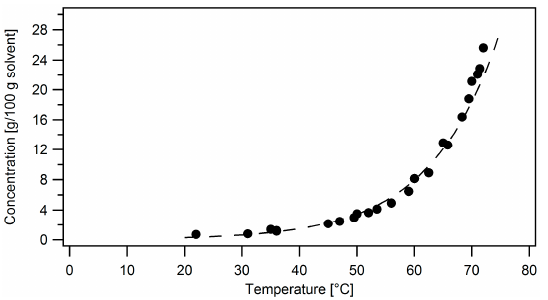
Figure 2. Solubility data of the API in ethanol denatured with MEK. The dashed line corresponds to the exponentially fitted solubility curve, given in Equation (2).